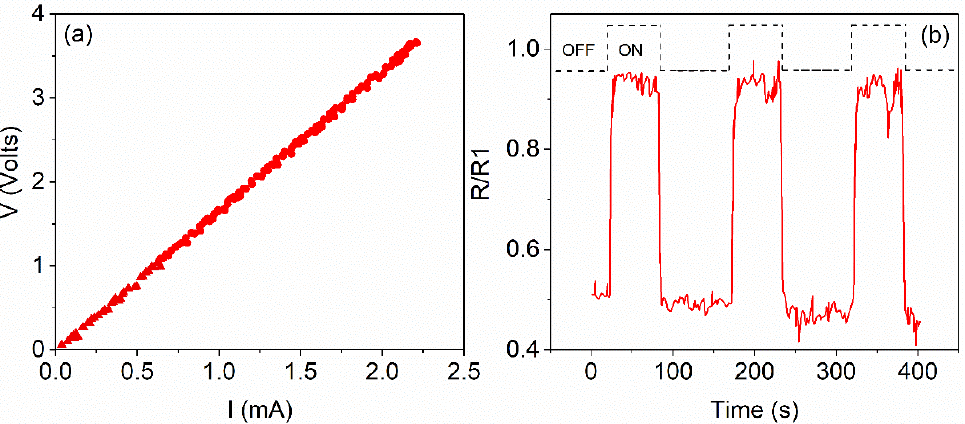
Figure 3. ( a ) Current–voltage (I–V) characteristics of VAGs in the normal condition. ( b ) Electrical switching characteristics for pulsed infra-red (IR) irradiation. switching characteristics for pulsed infra-red (IR)